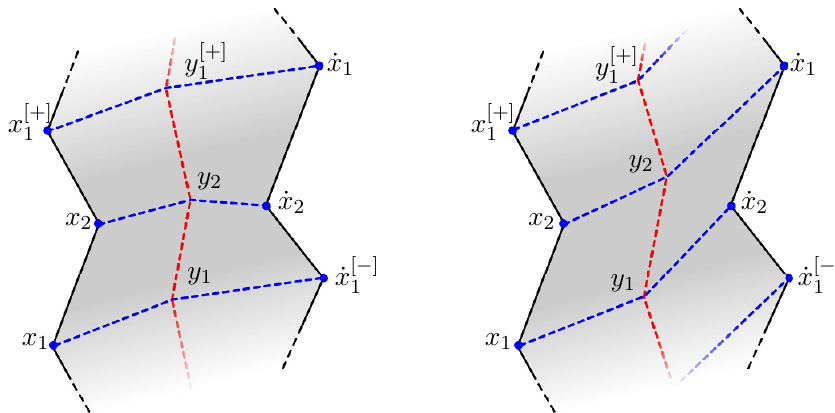
Figure 7 . The two diagrams that contribute to W (cid:12)shnet ( l ) at two-loop order. Blue (red) dashed 2 ; 2 lines correspond to (cid:30) 1 ( (cid:30) 2 ) propagators. These two diagrams come with an in(cid:12)nite set of diagrams that are related to them by a shift of one of the two Wilson lines by an integer number of periods, say _ x j ! _ x [ a ] j